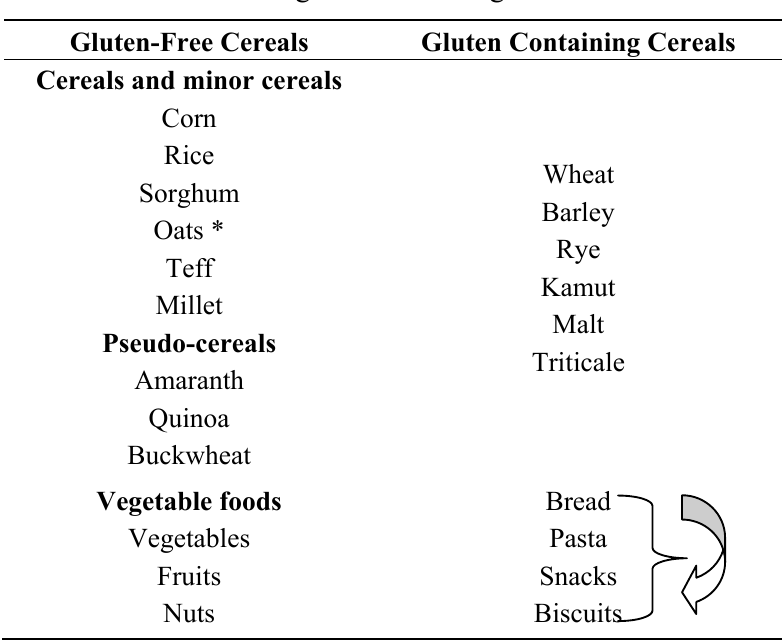
Table 1. Gluten-free and gluten containing cereals and other